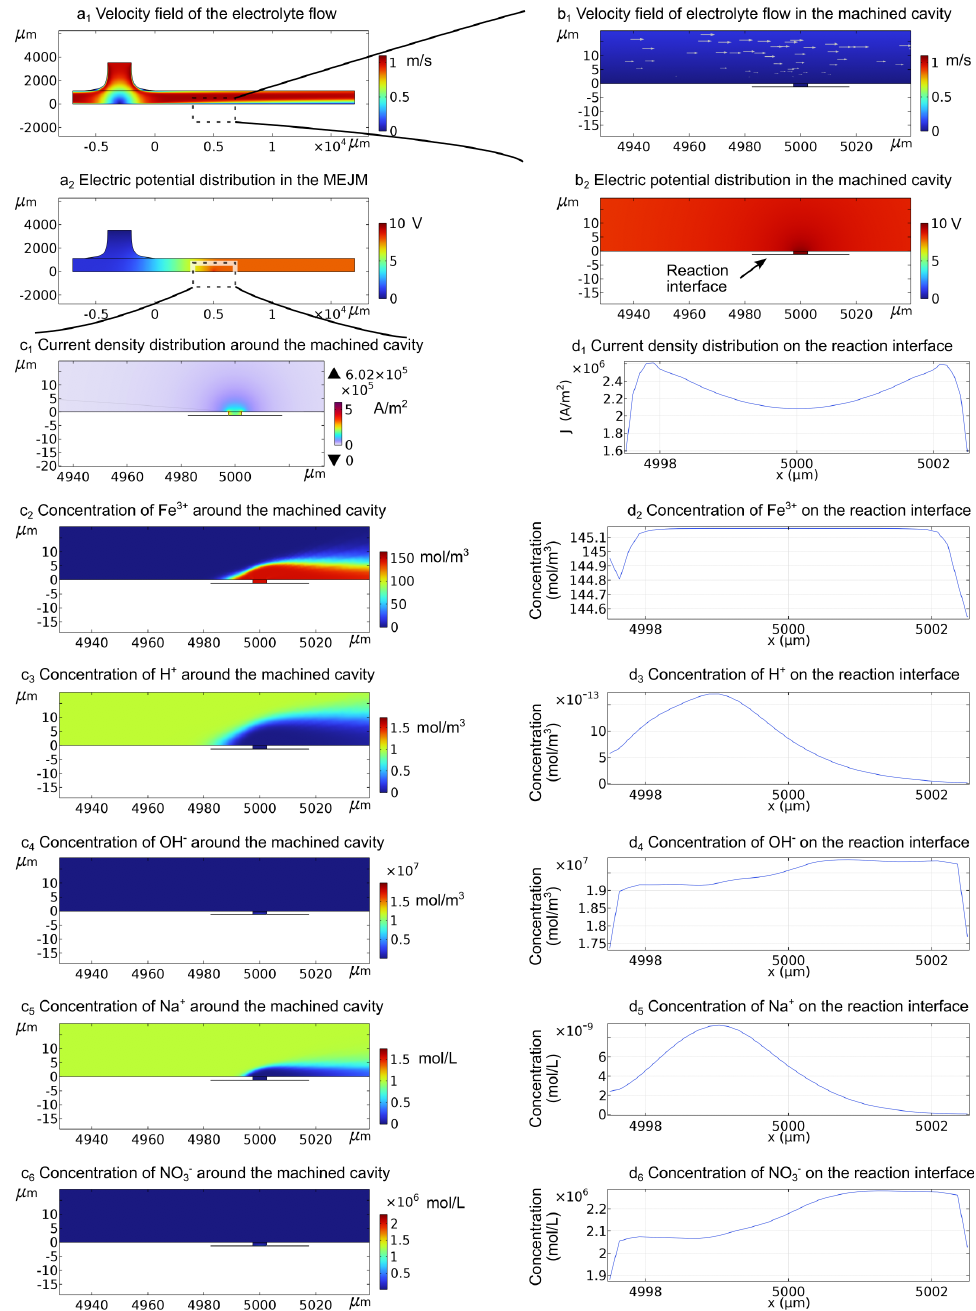
Figure A1. Simulation results at t = 0 s. ( a 1 ): velocity field of the electrolyte flow; ( b 1 ): velocity field of electrolyte flow in the machined cavity; ( a 2 ) electric potential distribution in the MEJM; ( b 2 ) electric potential distribution (V) in the machined cavity; ( c 1 ) normal current density distribution around the machined cavity; ( d 1 ): normal current density distribution on the reaction interface; ( c 2 – c 6 ): concentration ( mol/m 3 ) of Fe 3+ , H + , OH – , Na + , and NO 3 – around the machined cavity; ( d 2 – d 6 ): concentration (mol/m 3 ) of Fe 3+ , H + , OH – , Na + , and NO 3 – on the reaction